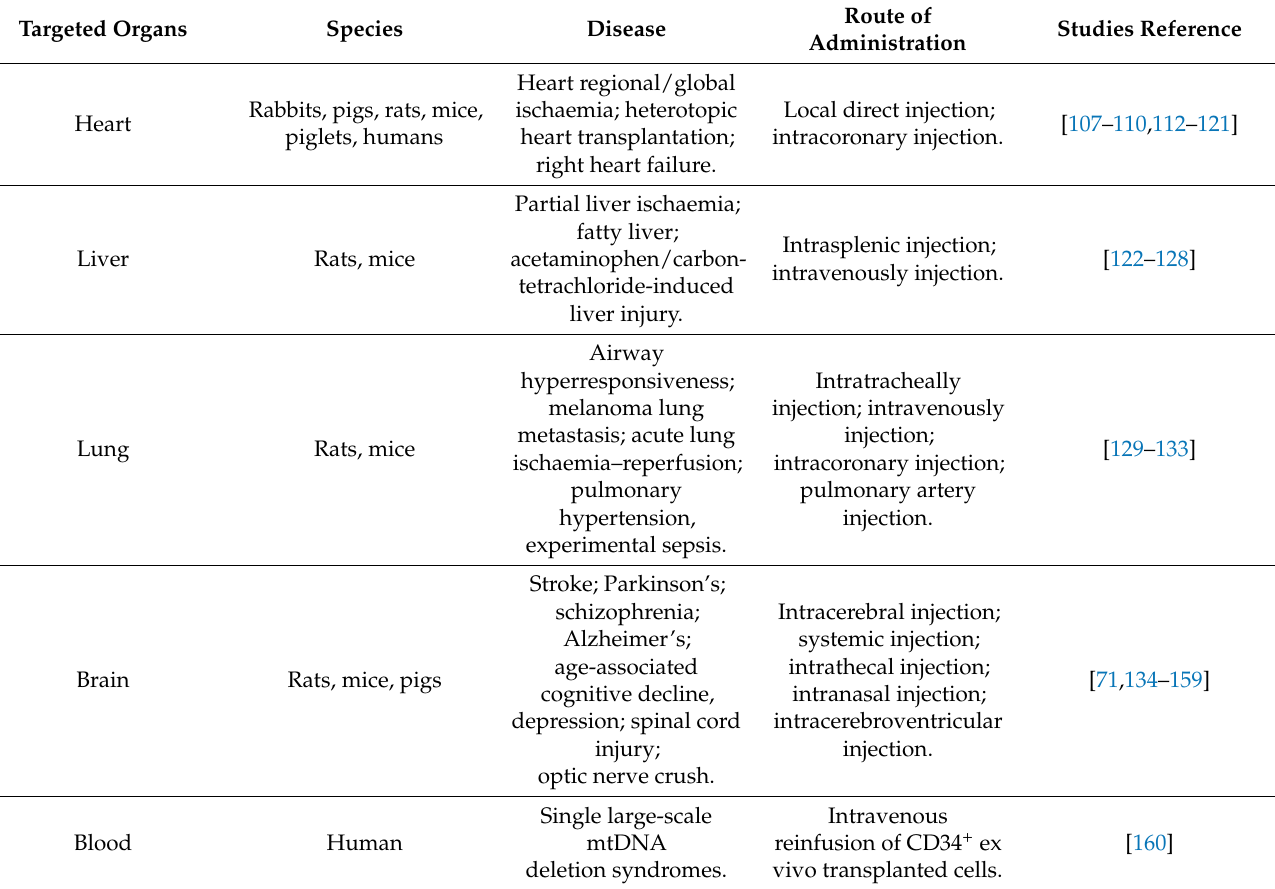
Table 2. In vivo research reports of mitochondrial